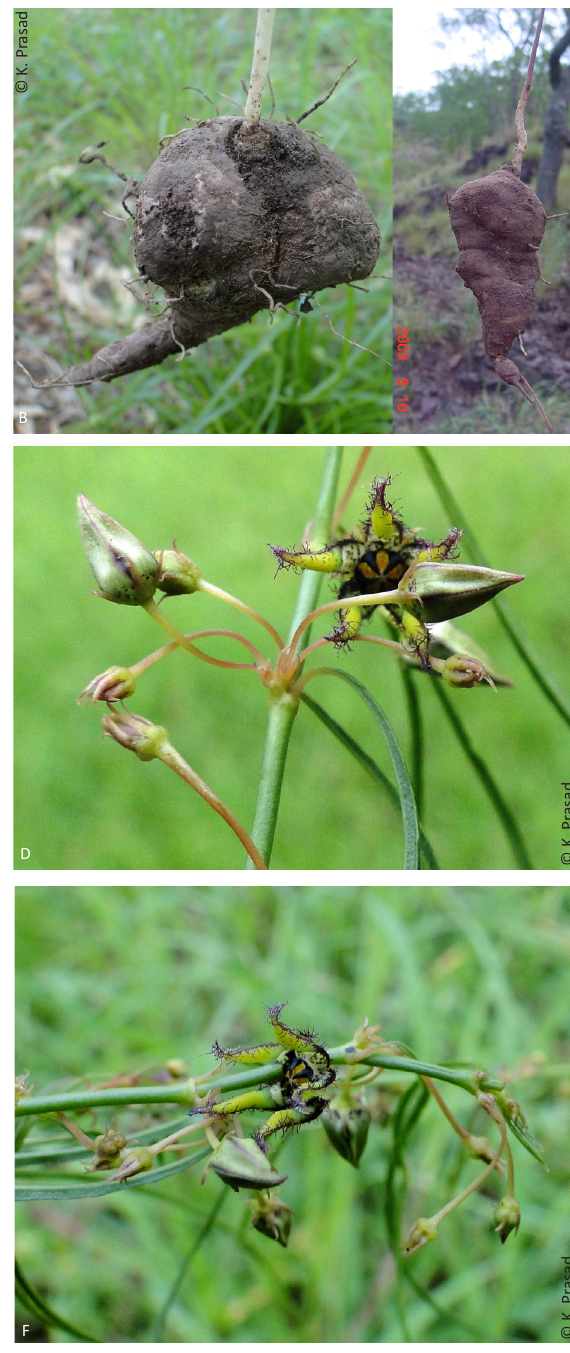
throughout, more dense at apex; lobes basally pale white with black spots and yellow above without any blotches. Corona ca. 3mm across, biseriate, glabrous; interstaminal corona obscurely 5-angled, cupular, forms a continuous ring around the gynostegium, brown; staminal corona 5-lobed, black; lobes appressed to